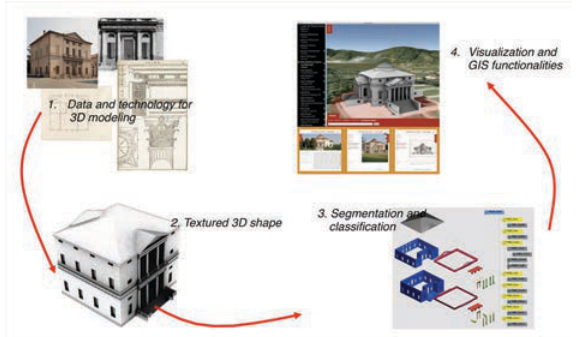
Figure 10. 3D model construction workflow